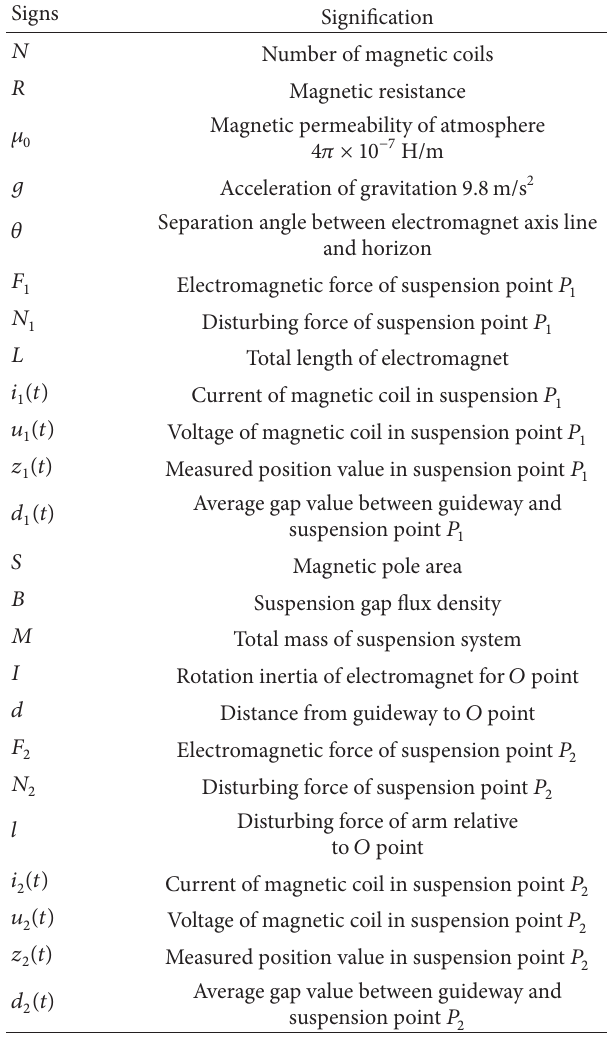
Table 1: Symbols in double suspension points